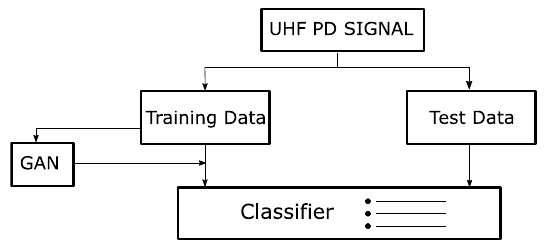
Figure 14. Classification of PD sources using a Generative Adversarial Network (GAN) model to generate more training data samples, adapted from [30].